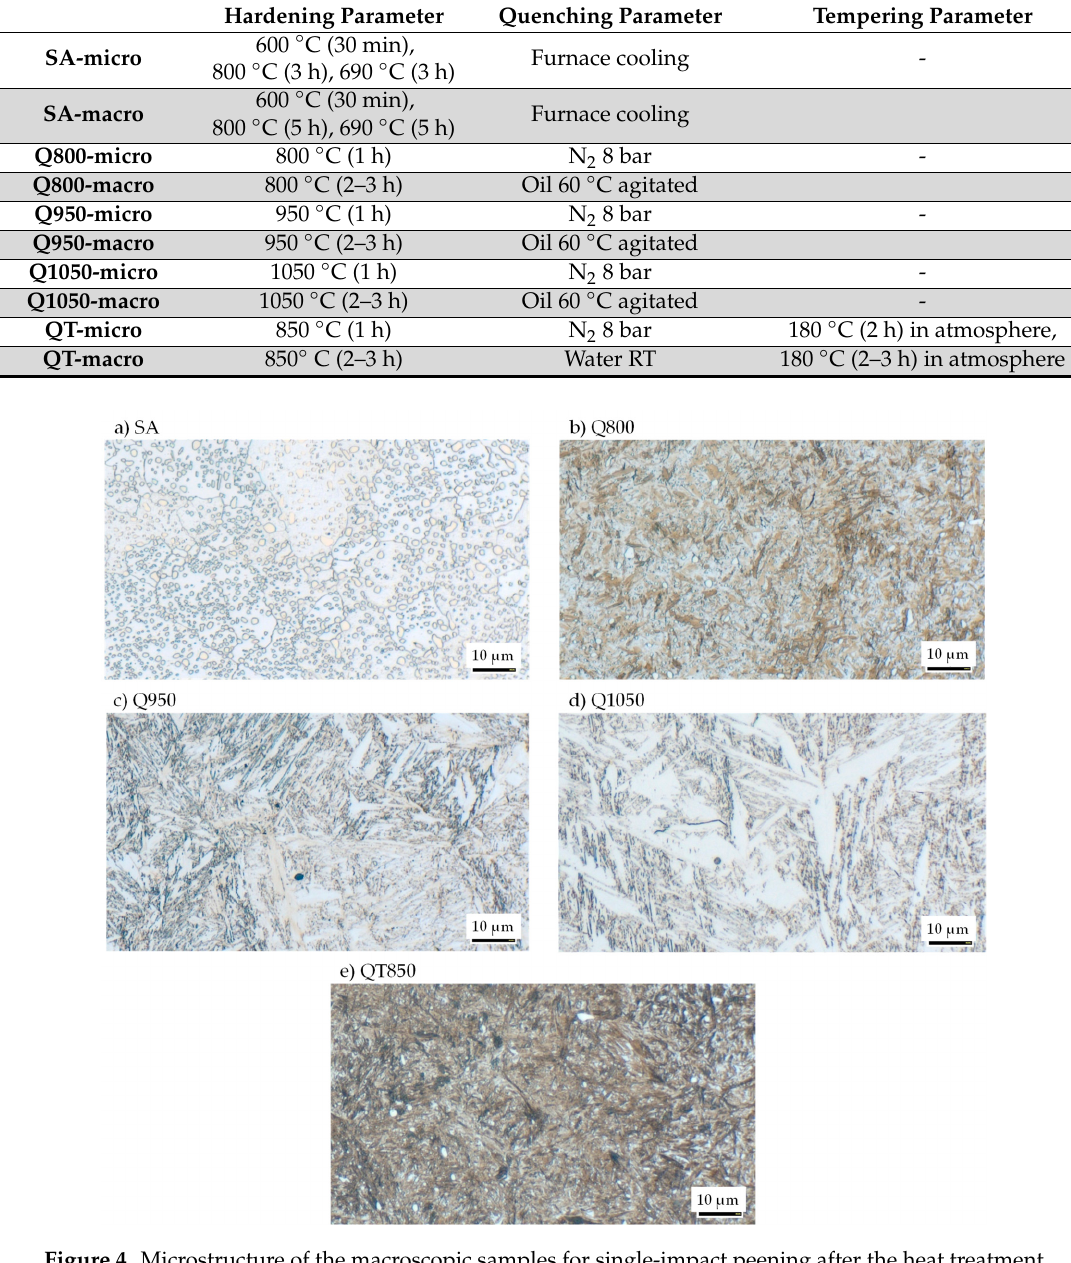
Figure 4. Microstructure of the macroscopic samples for single-impact peening after the heat treatment ( a ) SA, (b ) Q800, (c ) Q950, (d ) Q1050, (e ) QT); etched 25–60 s in 3% alcoholic HNO